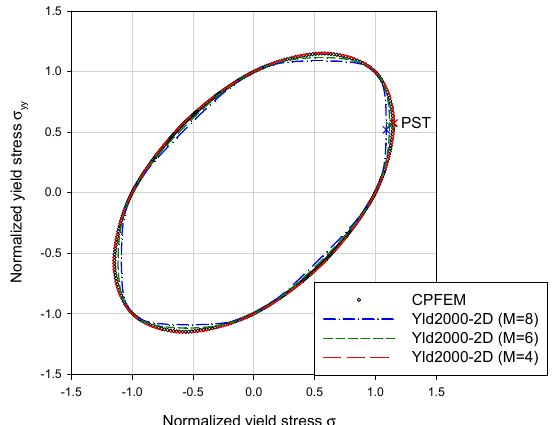
Figure 1. Comparison of the calculated yield surfaces based on crystal plasticity simulations and isotropic version of the Yld2000-2D function.